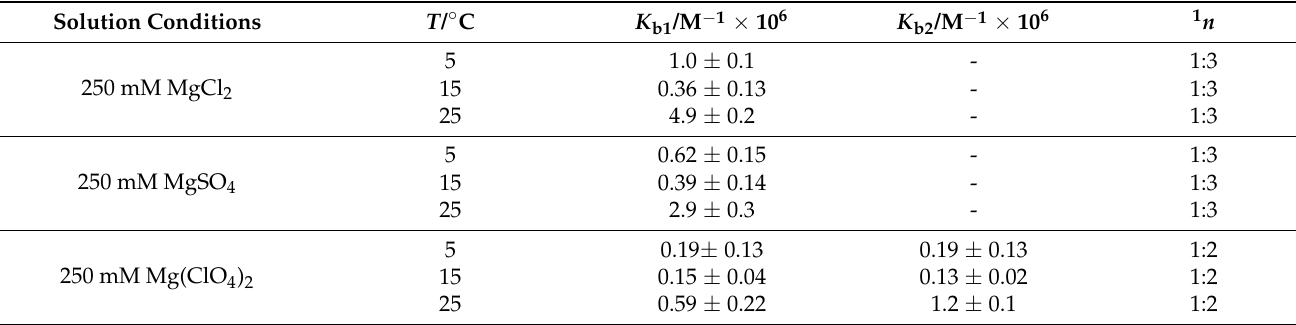
Table 1. Binding constants ( K b ) and stoichiometries for the BSA:ANS complex formation in 10 mM Tris-HCl buffer, pH 7.4, in the presence of the indicated salts and at temperatures ( T ) of 5, 15, and 25 ◦ C. Solution Conditions T / ◦